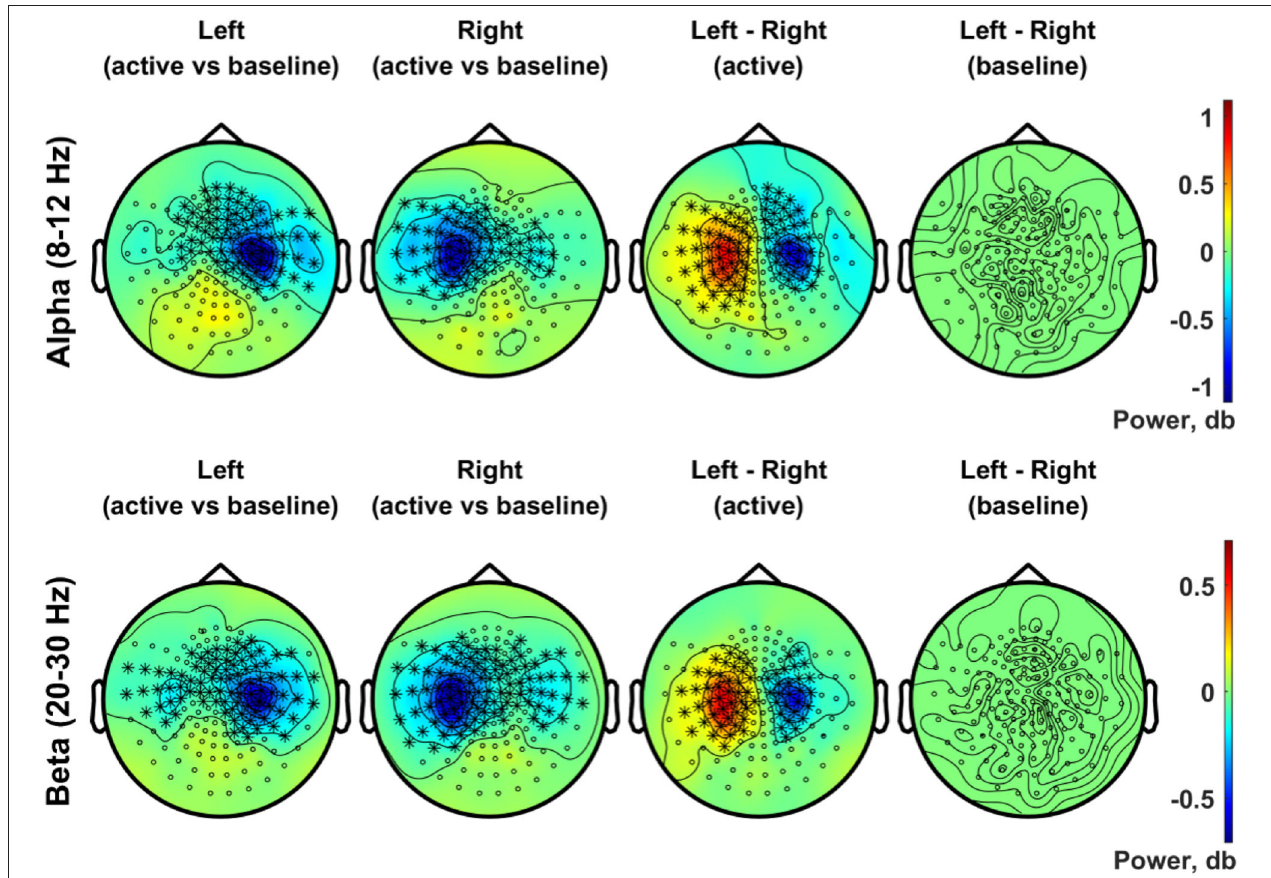
FIGURE 8 | Topographic distribution of spectral power in the alpha band (8–12 Hz, upper panel) and in the beta band (20–30 Hz, lower panel). In the upper panel, the distributions of the alpha (8–12 Hz) power changes during an active period between 0.2 and 0.4 s after stimulus relative to the baseline period ( − 0.4 to − 0.2 s) are plotted for the left (first column) and right (second column) index finger stimulation conditions. For each stimulation condition, statistical significance of the power change relative to baseline was evaluated by using a cluster-based permutation test ( N = 29, 1,000 permutations, cluster-defining threshold p < 0.05, α = 0.05). In addition, the difference in the alpha power for the active period between left and right stimulation conditions, as well as the difference in baseline alpha activity between conditions, was also statistically tested for significance ( N = 29, cluster-based permutation test, 1,000 runs, cluster-defining threshold p < 0.05, α = 0.05). Channels associated with significant clusters are indicated by asterisks. In the lower panel, the same analyses were applied as the upper panel but for oscillatory powers in the beta band (20–30 Hz). All plots are obtained for planar